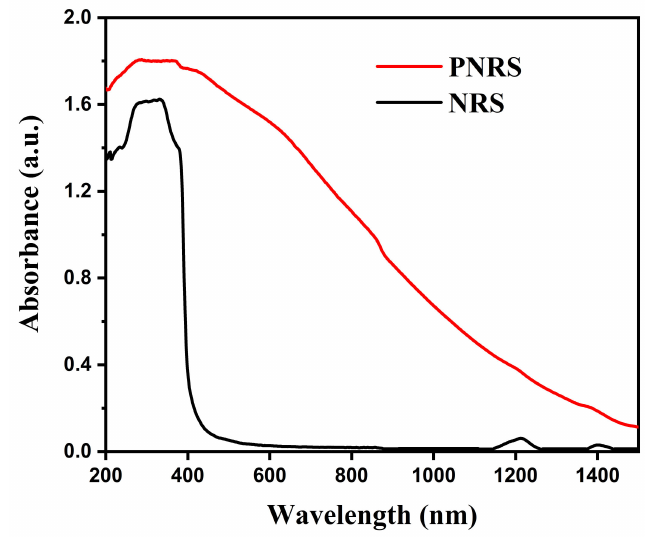
Figure 5. UV–Vis–NIR absorption spectra of PNRS and NRS.